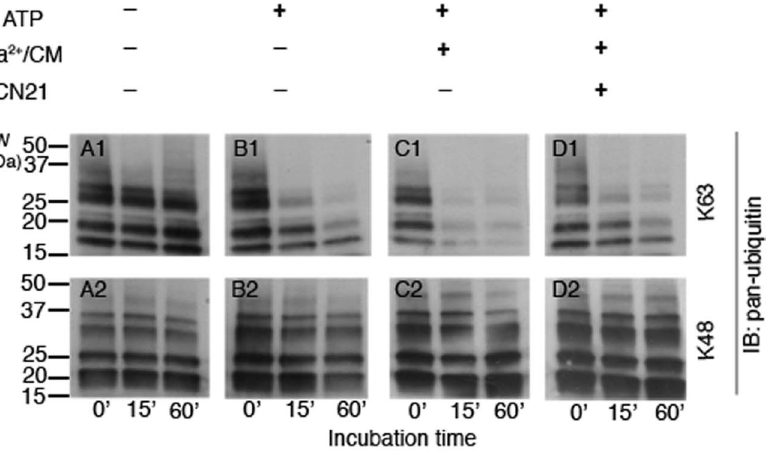
Figure 4. Activation of CaMKII upregulates deubiquitinase activity at the PSD. PSD fractions were treated under four different conditions designed to manipulate CaMKII activity as indicated above. The samples were subsequently incubated with either K63- or K48-linked polyubiquitins for different time intervals, followed by Western immunoblotting with a pan-ubiquitin antibody. The rate of degradation of K63-linked polyubiquitins increased when the PSD was pre-incubated with ATP, Ca 2 + /calmodulin, conditions that promote CaMKII activation (C1). Inclusion of CN21, a CaMKII inhibitor, prevented Ca 2 + /calmodulin-dependent upregulation of deubiquitinase activity (D1). On the other hand the rate of degradation of K48- linked polyubiquitins did not show appreciable change in correlation with CaMKII activity (C2). Two independent experiments showed similar